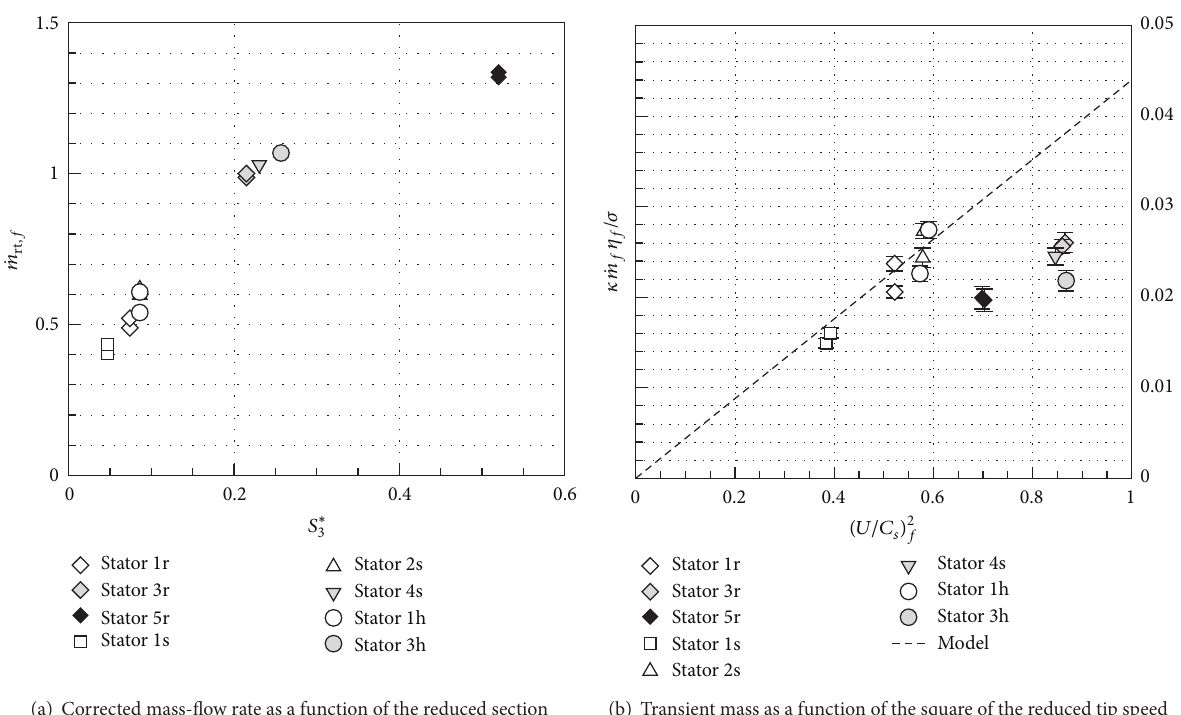
Figure 7: Agreement between theoretical prediction and experimental results for all the configurations, for a final operating point of 𝜋 𝑡 = 1.6 .